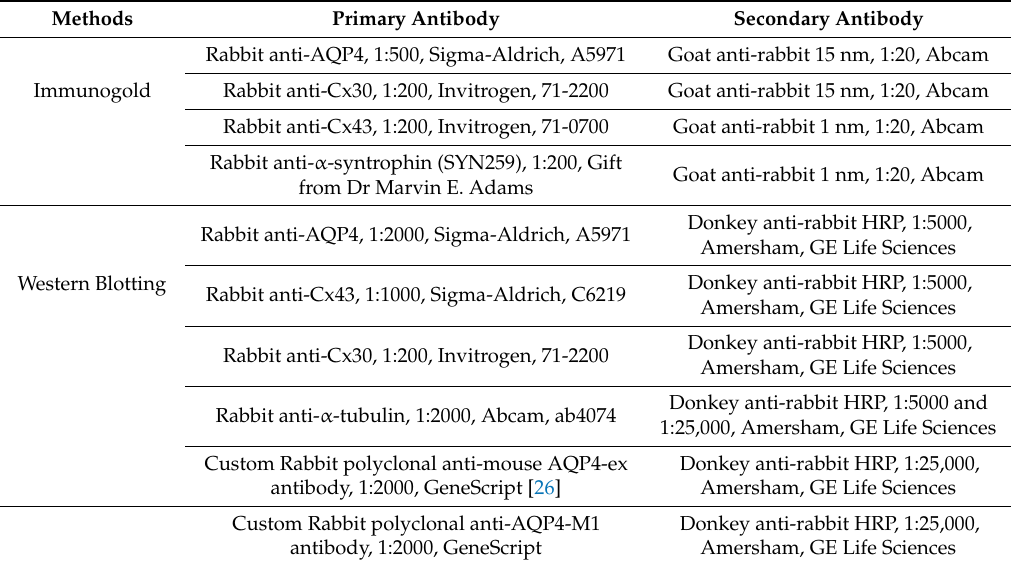
Table 1. Antibodies. The following antibodies used in this